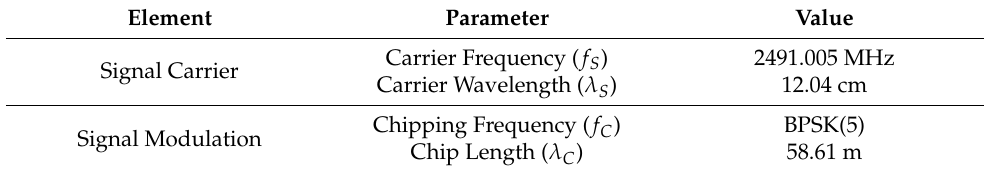
Table 2. Characteristics of the proposed LCNS signal.